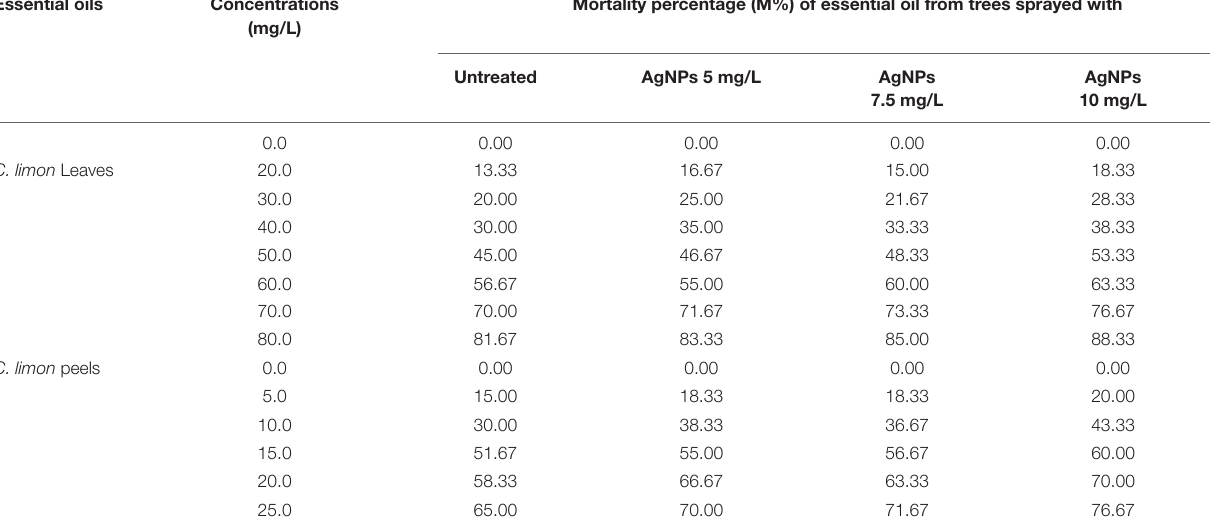
TABLE 7 | Mortality percentage of C. limon essential oil against S. oryzae . Essential